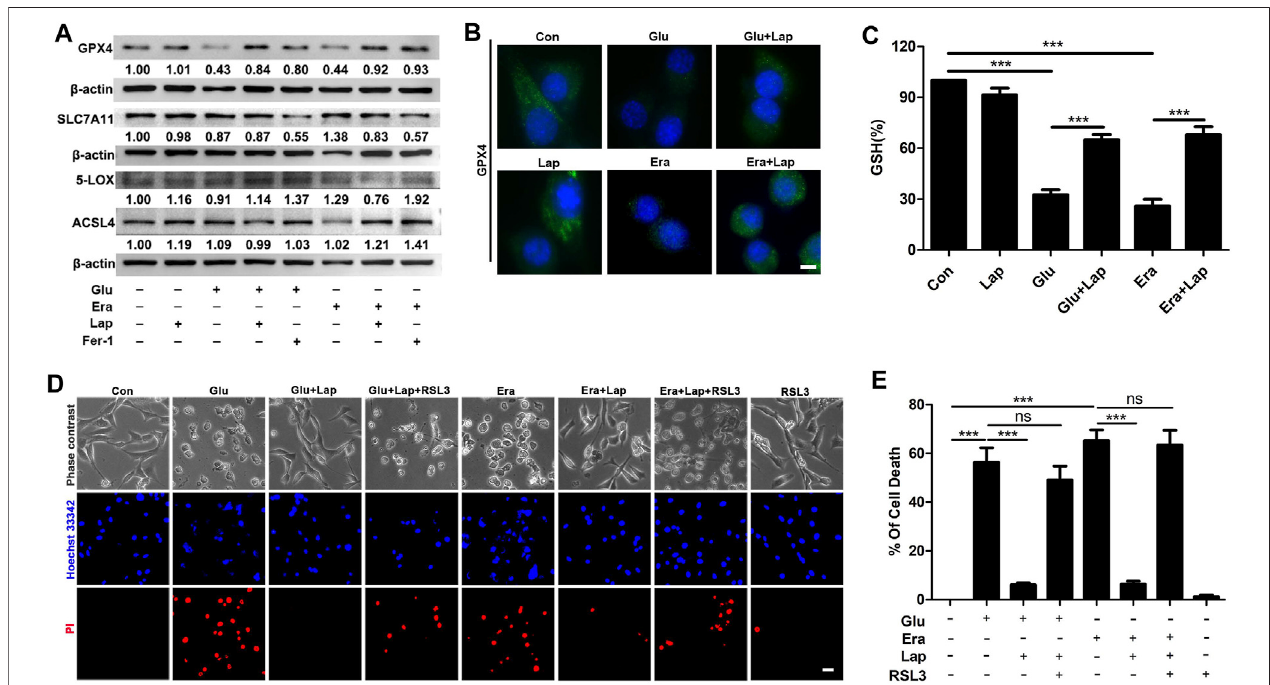
FIGURE6| LapatinibinhibitsneuronalferroptosisbyblockingthedownregulationofGPX4 (A) Effectsoflapatinib(Lap)orferrostatin-1(Fer-1)ontheexpressionsof ferroptosis-relatedproteins includingglutathione peroxidase 4(GPX4), solute carrier family 7member 11(SLC7A11),5-Lipoxygenase(5-LOX) oracyl-CoA synthetase 4 (ACSL4)inHT22celldeathmodelinducedbyglutamate(Glu)orerastin(Era).ThevaluebelowthebandisobtainedviaImageJanalysis (B) Immuno fl uorescenceanalysis of GPX4 expression after pretreatment for 2 h with Lap (10 μ M), followed by exposure to Glu or Era for another 8 h in HT22 cells. Scale bar: 50 μ m (C) GSH level wasassessedfollowingLap(10 μ M)pretreatmentfor2 h (D,E) EffectsofGPX4inhibitionbyras-selectivelethalsmallmolecule3(RSL3)(1 nM)ontheneuroprotectionof Lap(10 μ M)againstGlu-orerastin-inducedcelldeathinHT22cells.Scalebar:200 μ m.Allresultswereshownasthemean ± SEMfromthreeindependentexperiments, ns means the difference is not statistically signi fi cant, *** p <